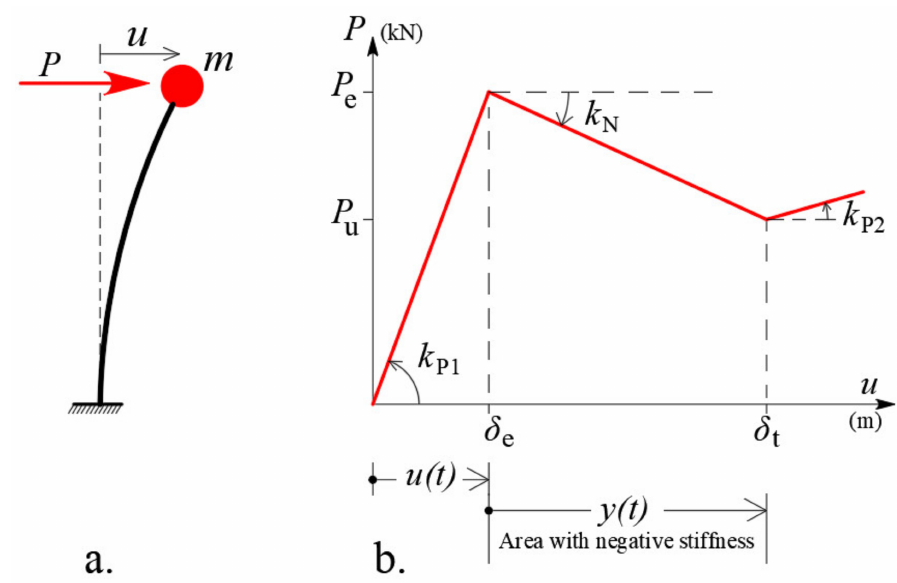
Figure 1. ( a ) SDOF oscillator; ( b ) positive and negative